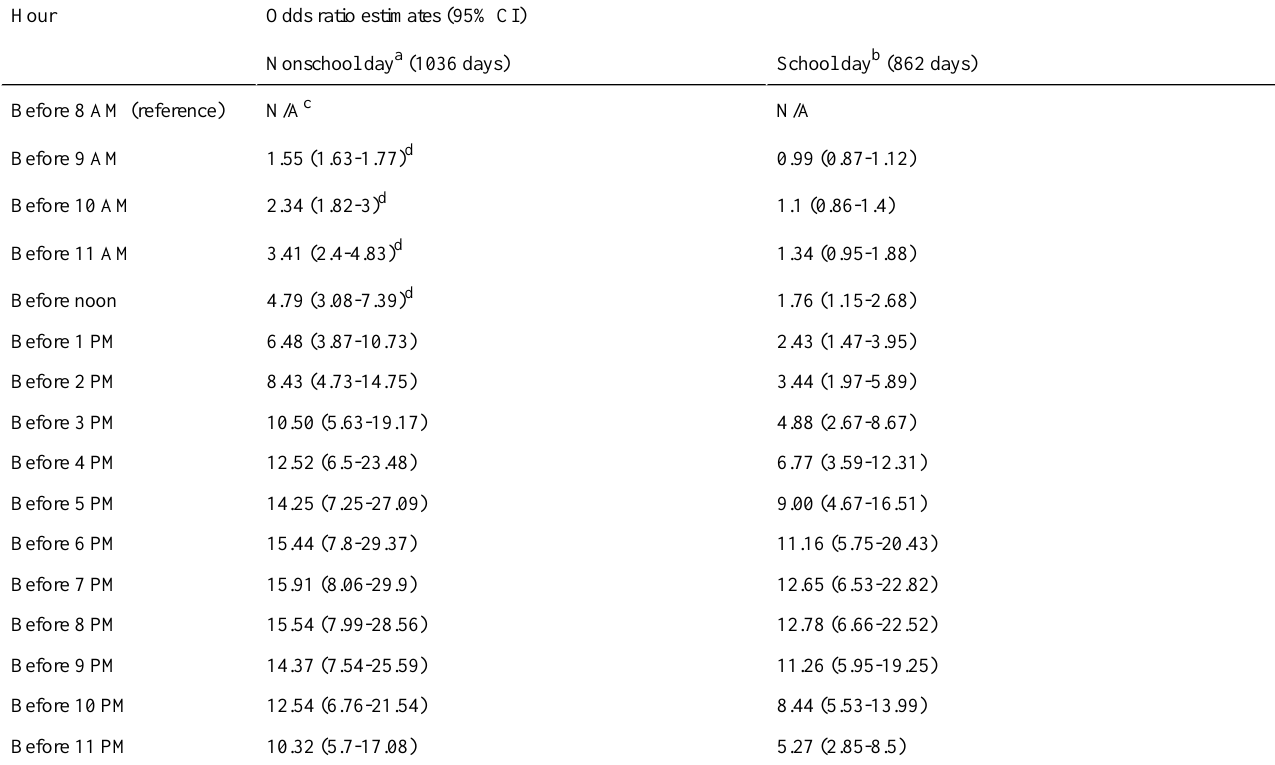
Table 5. Moderating effect of school day on odds ratio estimates of time of average moderate-to-vigorous physical activity accumulation. Odds ratio estimates (95%